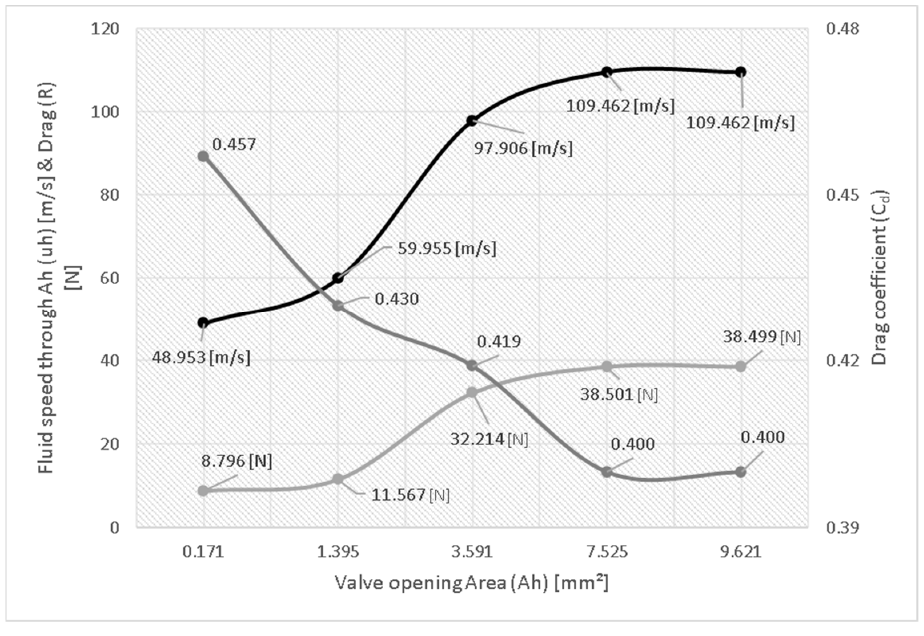
Figure 6. Drag of the ball − 50 (°C).